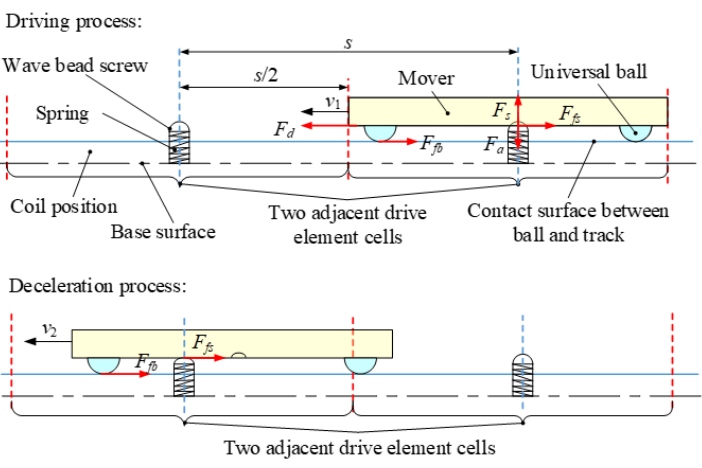
Figure 7. Transfer process between two adjacent drive element